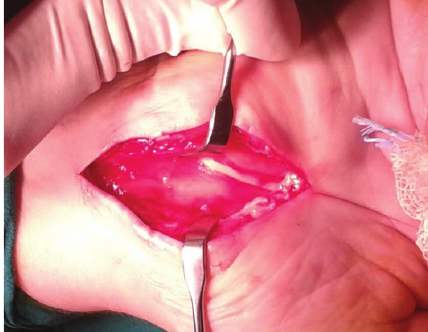
Figure 2: Presence of palmaris profundus over the median nerve during the revision.